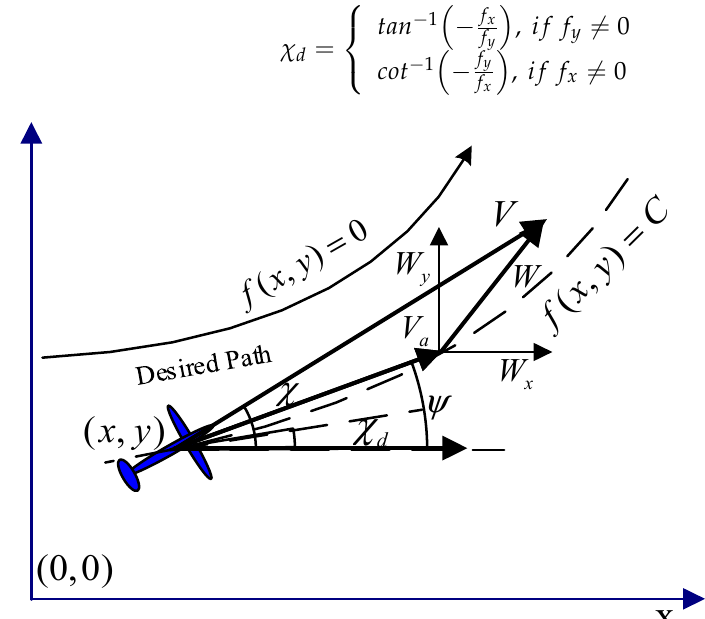
Figure 1. Path level set and the position of the UAV with respective to the desired path.